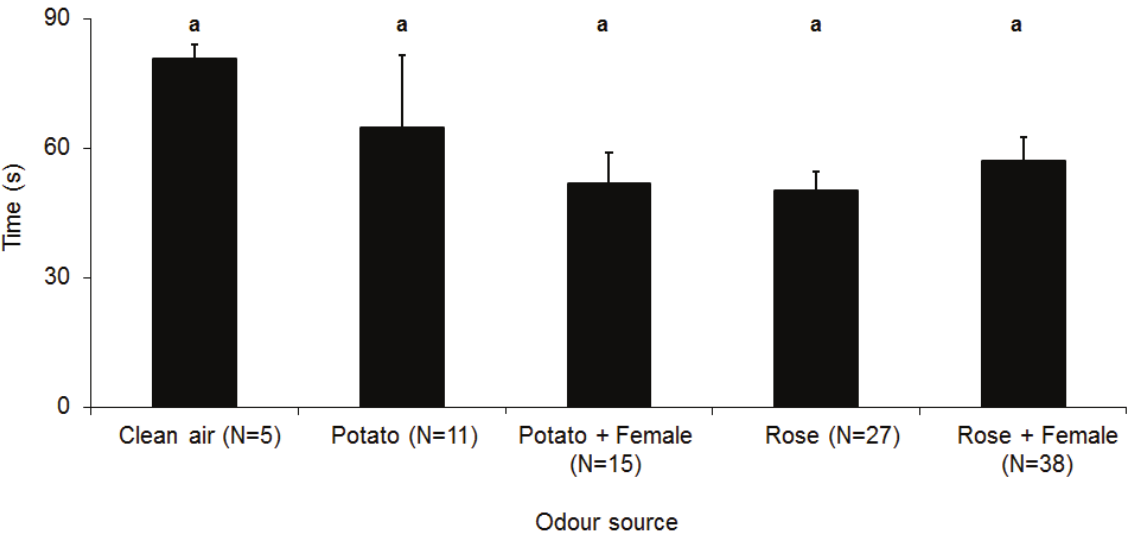
Figure 4. Mean time (X ± SEM) taken by M. euphorbiae males to reach different odour sources in wind tunnel assays (N = number of responding males). Columns with different letters are significantly different (Tukey’s HSD, p <